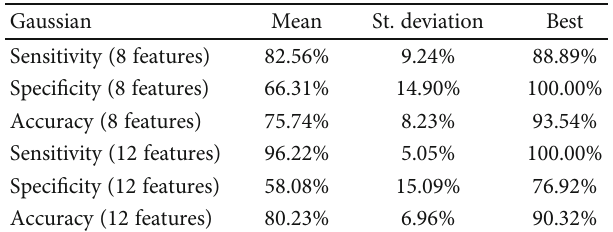
Table 16: Results of SVM with a Gaussian kernel.